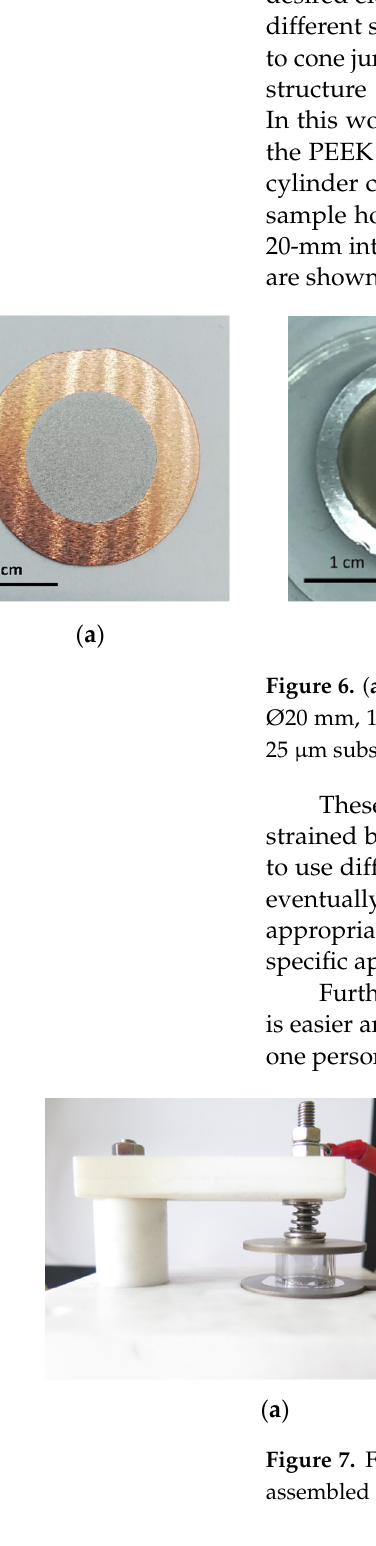
Figure 5. Open and closed cylinder with heights of 1 cm ( a ) and ( b ), and 2 cm ( c ) and ( d ).